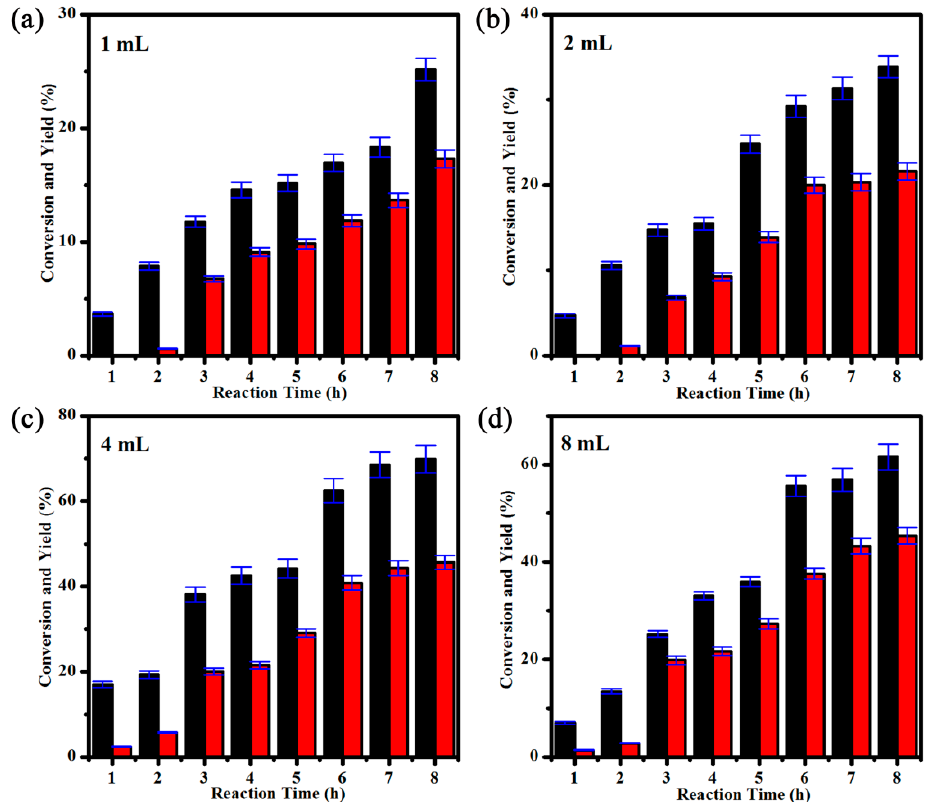
Figure 5. Effect of H 2 O 2 dosage ( a ) 1 mL; ( b ) 2 mL; ( c ) 4 mL and ( d ) 8 mL on the oxidation of α -phenethyl alcohol (1.5 mmol α -phenethyl alcohol, 0.01 mmol 1 , 20 mL acetonitrile, 75 ◦ C, 8 h). The black bars represent the conversion of α -phenethyl alcohol; the red bars represent the yield of acetophenone.